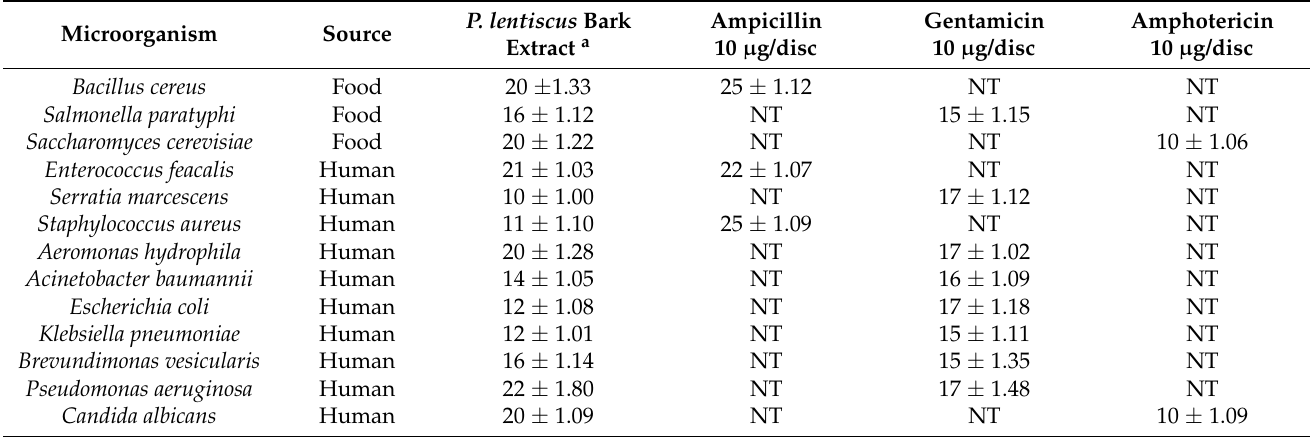
Table 2. The antimicrobial activity of the P. lentiscus bark